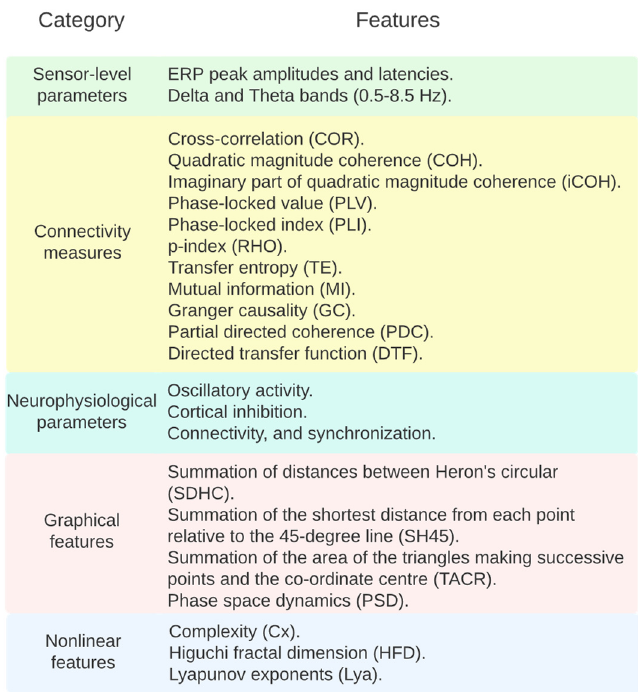
Figure 6. EEG features in schizophrenia. Table 4. References and accuracy obtained with EEG features.